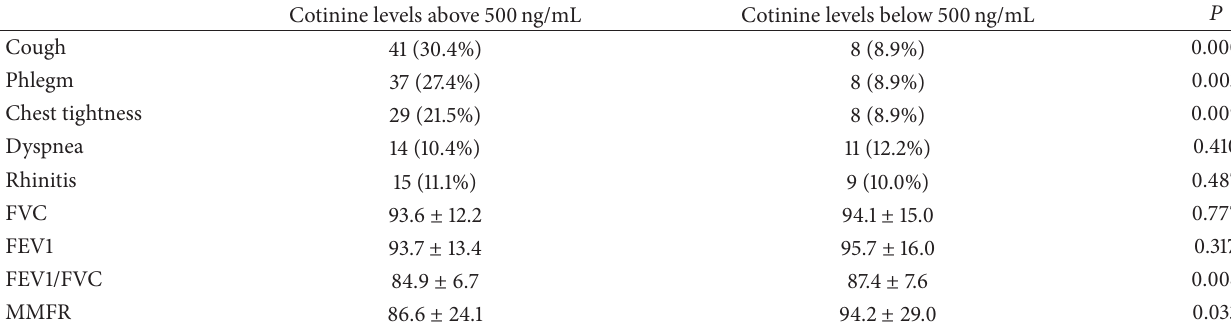
Table 2: Respiratory tract complaints and respiratory function tests according to smoking status.